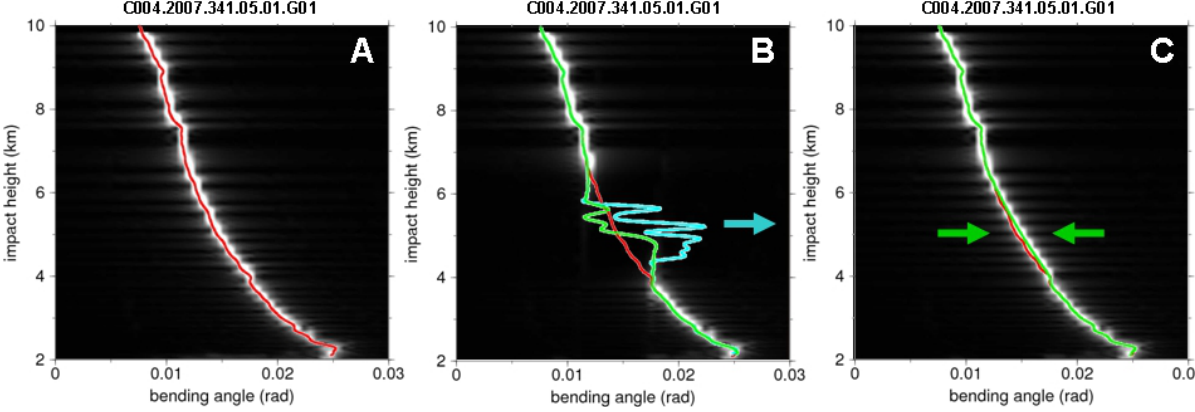
Fig. 12. Same as Fig. 11 but for high-latitude occultation. Green and blue lines in panel B correspond to the use of RO signal down to − 80km and − 150km straight-line